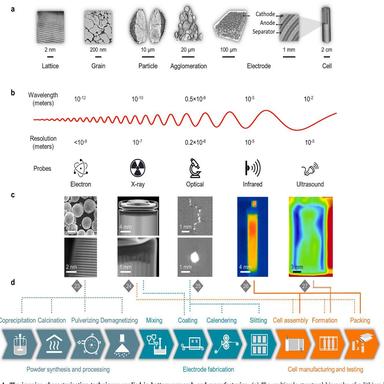
The imaging characterization techniques applied in battery research and manufacturing. (a) The multiscale structural hierarchy of a lithium-ion battery. Reproduced with permission. Copyright 2021, Elsevier. (b) Several broadly used imaging probes for battery research and manufacturing, including electron, X-ray, optical photons, infrared, and ultrasound. (c) Examples of images obtained using the corresponding imaging probes shown in (b). The numbers inside the diamond-shaped boxes in the figure